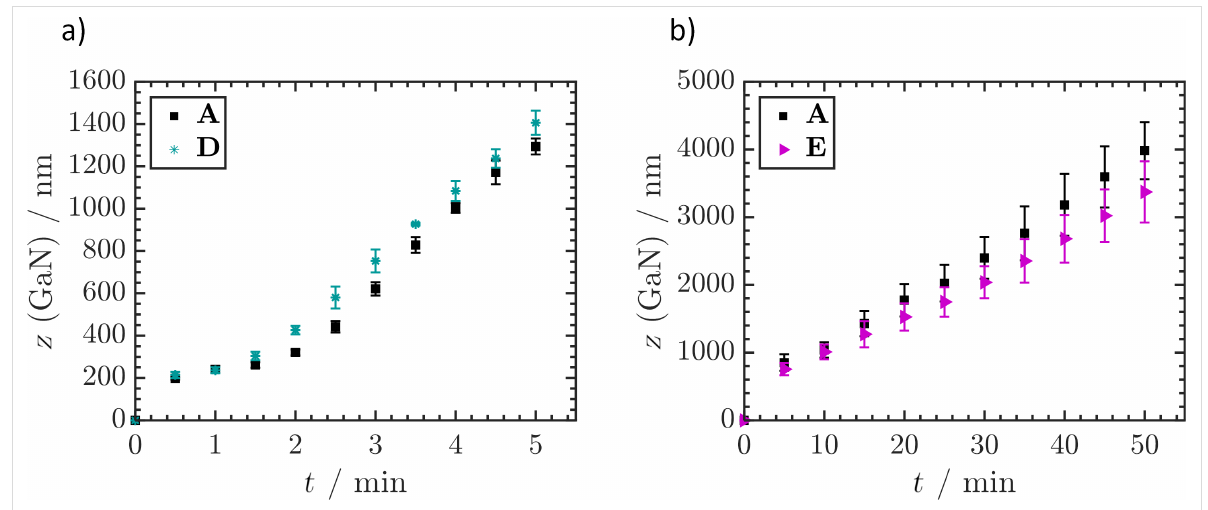
Figure 7: ICP-OES determined average GaN removal z (GaN) of A and D (a) and A and E (b) during etching in 30 wt % KOH at 80 °C. Values were determined as mean ± SDM, n = 3.